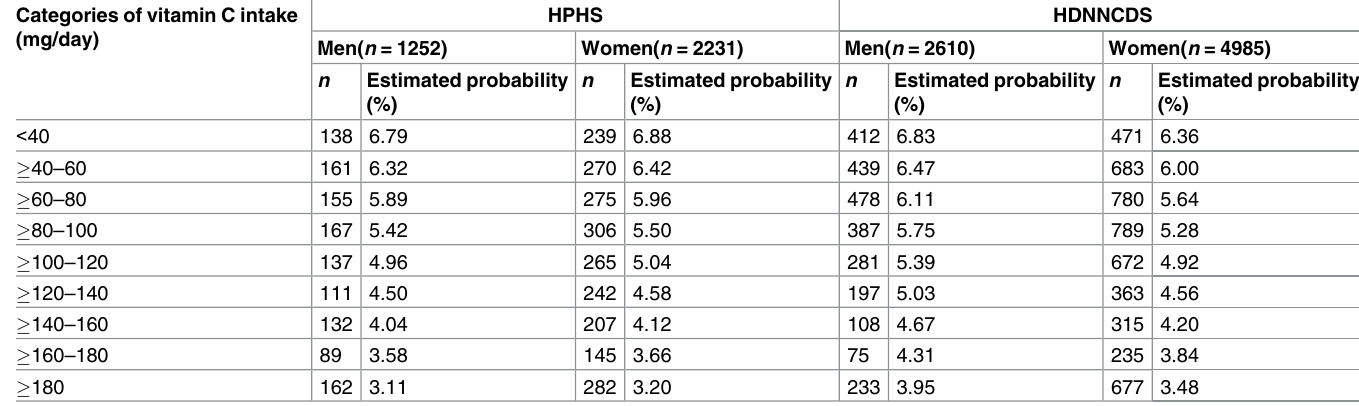
Table 5. Estimated diabetes probability by categories of vitamin C intake after adjusted for potential confounders with assumed values in logis- tics regression models in the Harbin People’s Health Study (HPHS, 2008–2012) and in the Harbin Cohort Study on Diet, Nutrition and Chronic Non-communicable